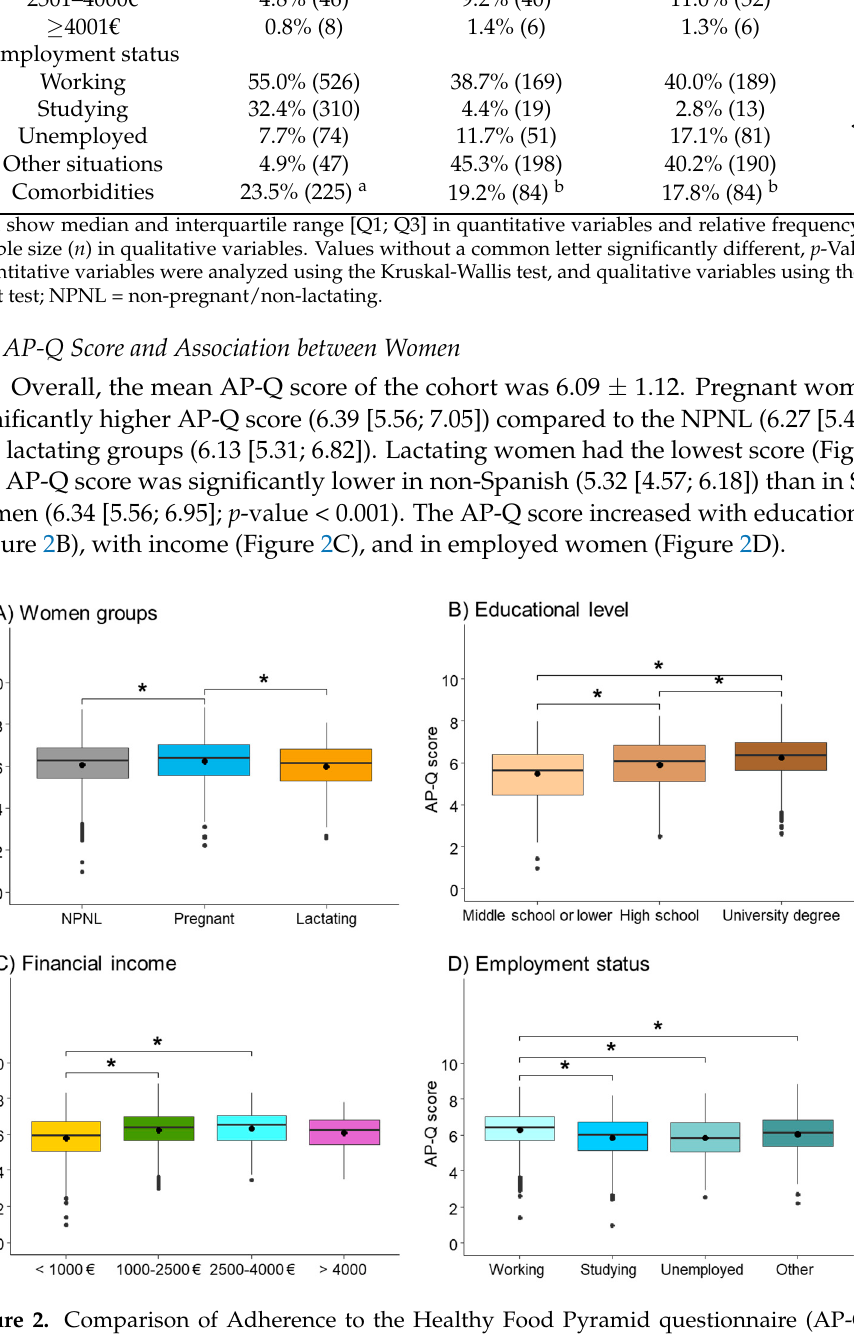
Figure 2. Comparison of Adherence to the Healthy Food Pyramid questionnaire (AP-Q) score between women groups ( A ), educational level ( B ), financial income ( C ), and employment status ( D ). Data has been shown as a box plot showing median and interquartile range. Mean is shown as a center dot. * p -Value < 0.05 by Dunn’s pairwise comparison to adjust for multiple comparisons. NPNL = non-pregnant/non-lactating.